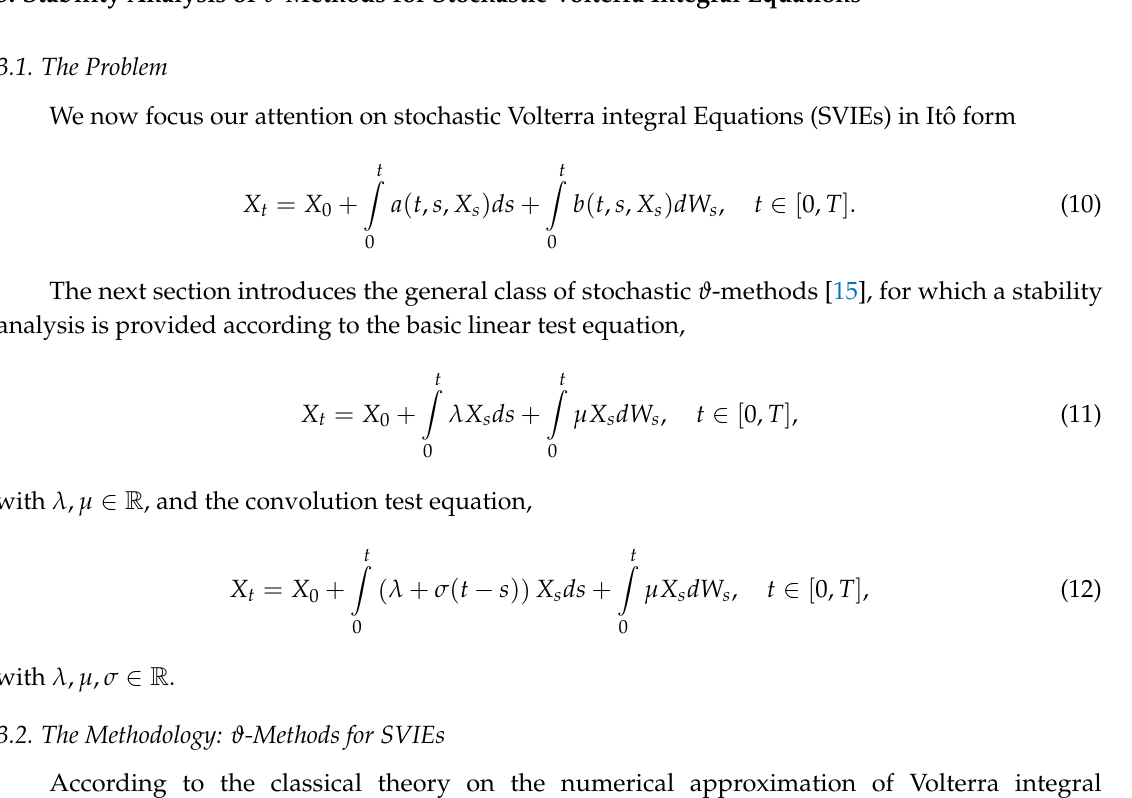
Figure 2. Graphs of | (cid:101) σ 2 line, the lowest one) over η , for the Adams–Moulton method applied to Problem (2), with g = 1, h = 10 − 2 , ε =